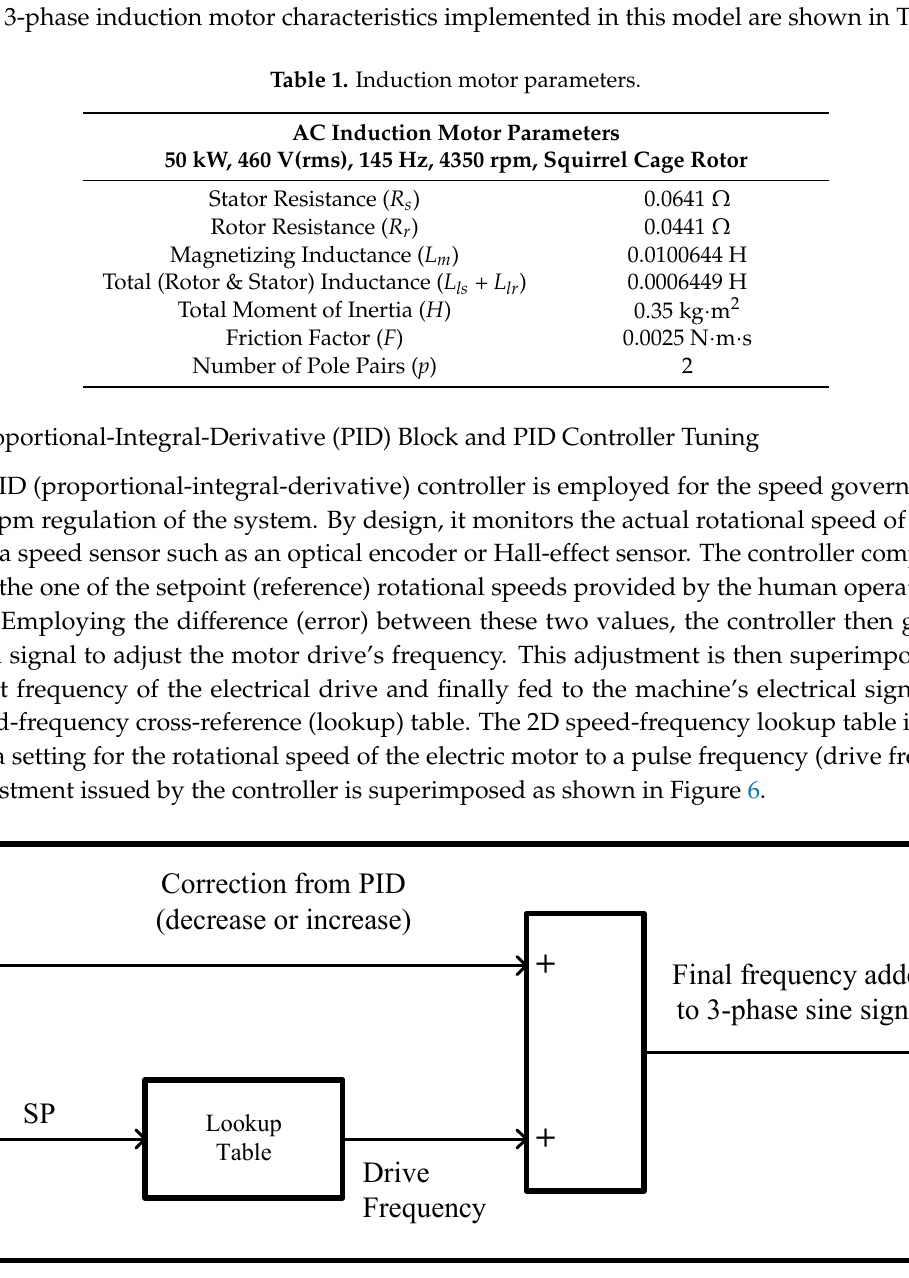
Figure 6. Rotational speed-drive frequency lookup table and proportional-integral-derivative (PID) perturbation.